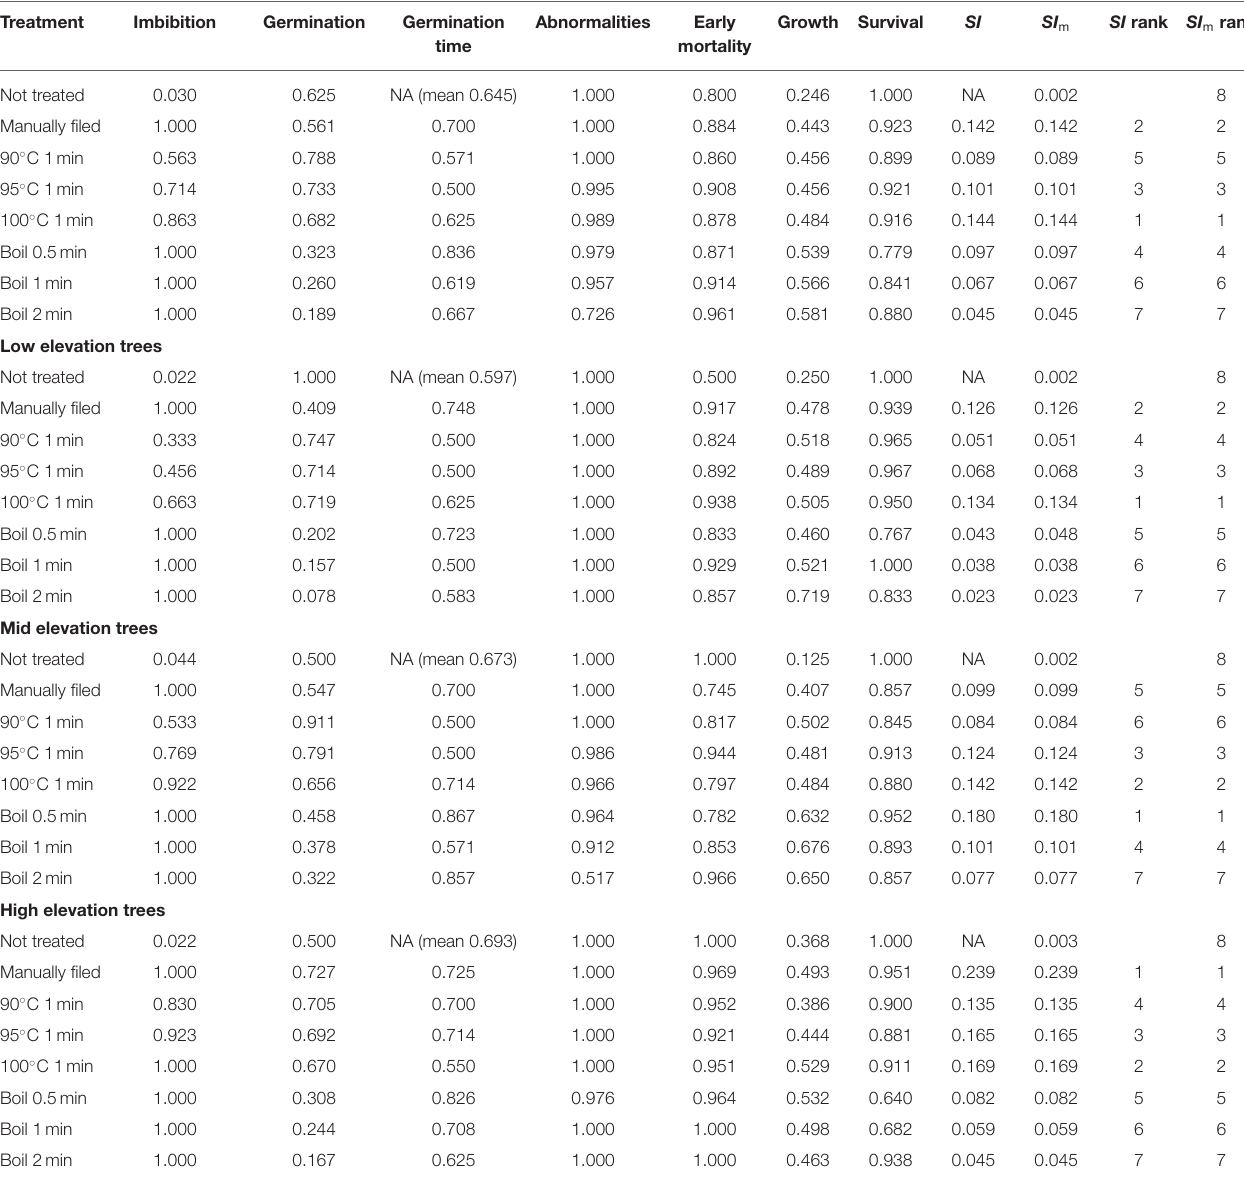
TABLE 2 | Scarification index ( SI ), values for each constituent process, and the treatment rank for koa seeds from nine trees subjected to all scarification treatments, and mother trees separated by elevation range (all after up to 15 attempts combined). Treatment Imbibition Germination Germination Abnormalities Early Growth Survival SI SI m SI rank SI m time mortality